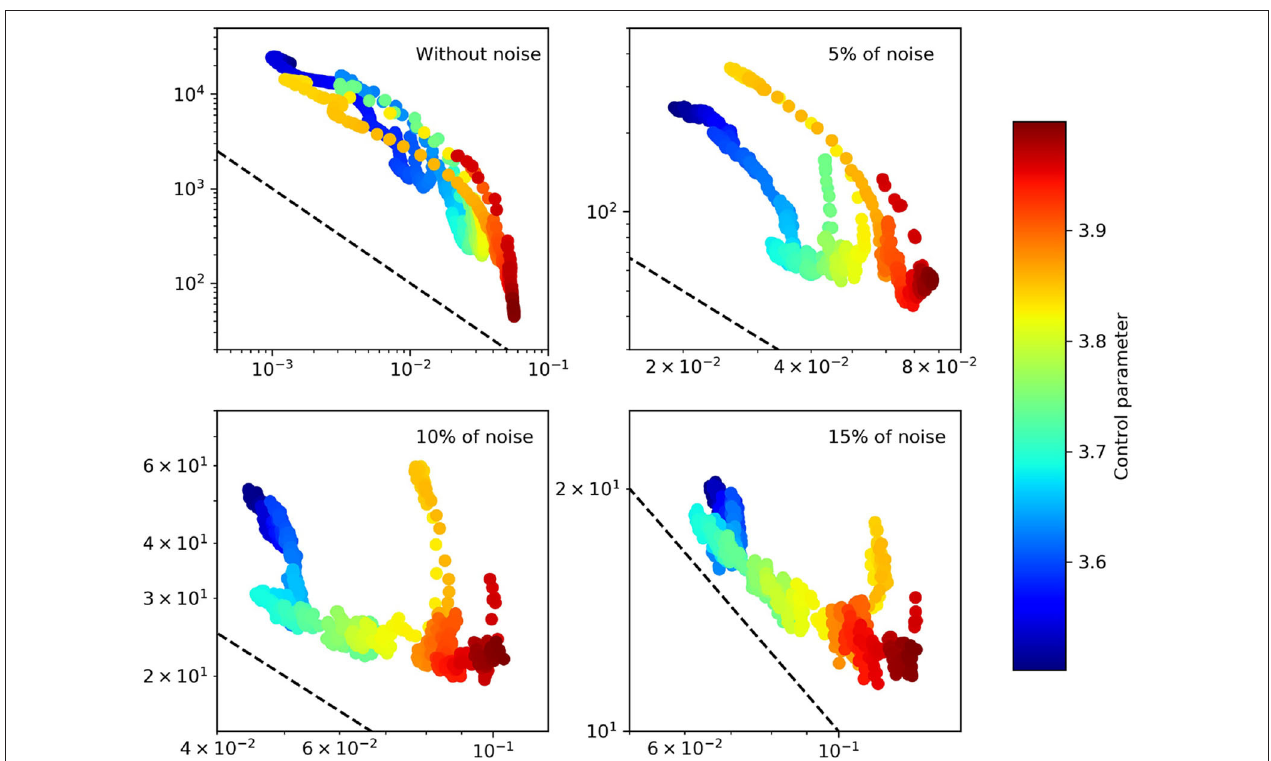
FIGURE 3 | Trajectory of the logistic map in the